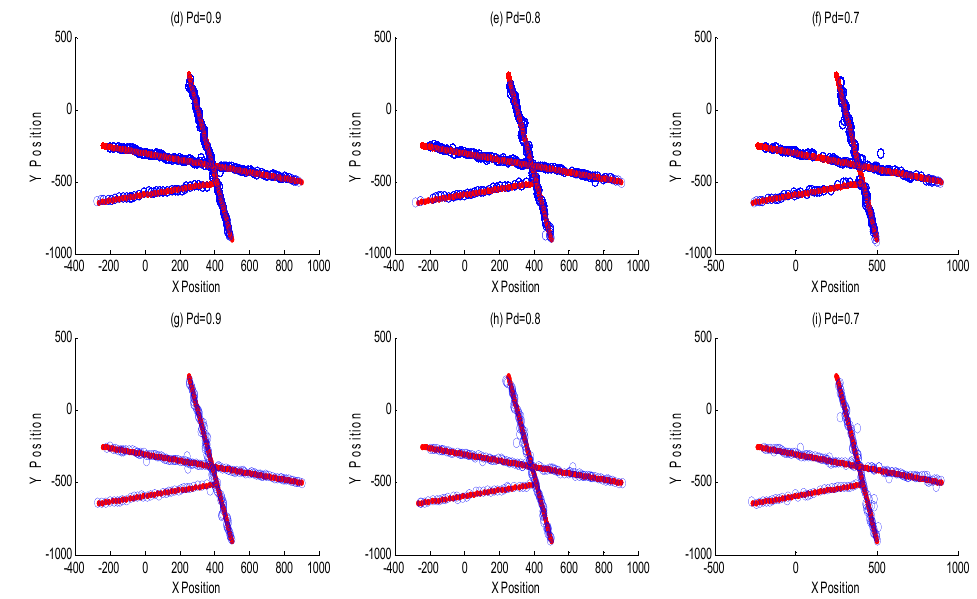
Figure 7. Multisensor tracking results at different detection probabilities. ( a – c ) are classical GMPHD filter tracking results at different detection probabilities; ( d – f ) are two sensors global estimations by MDC-MTF algorithm; ( g – i ) are three sensors global estimations by MDC-MTF algorithm.